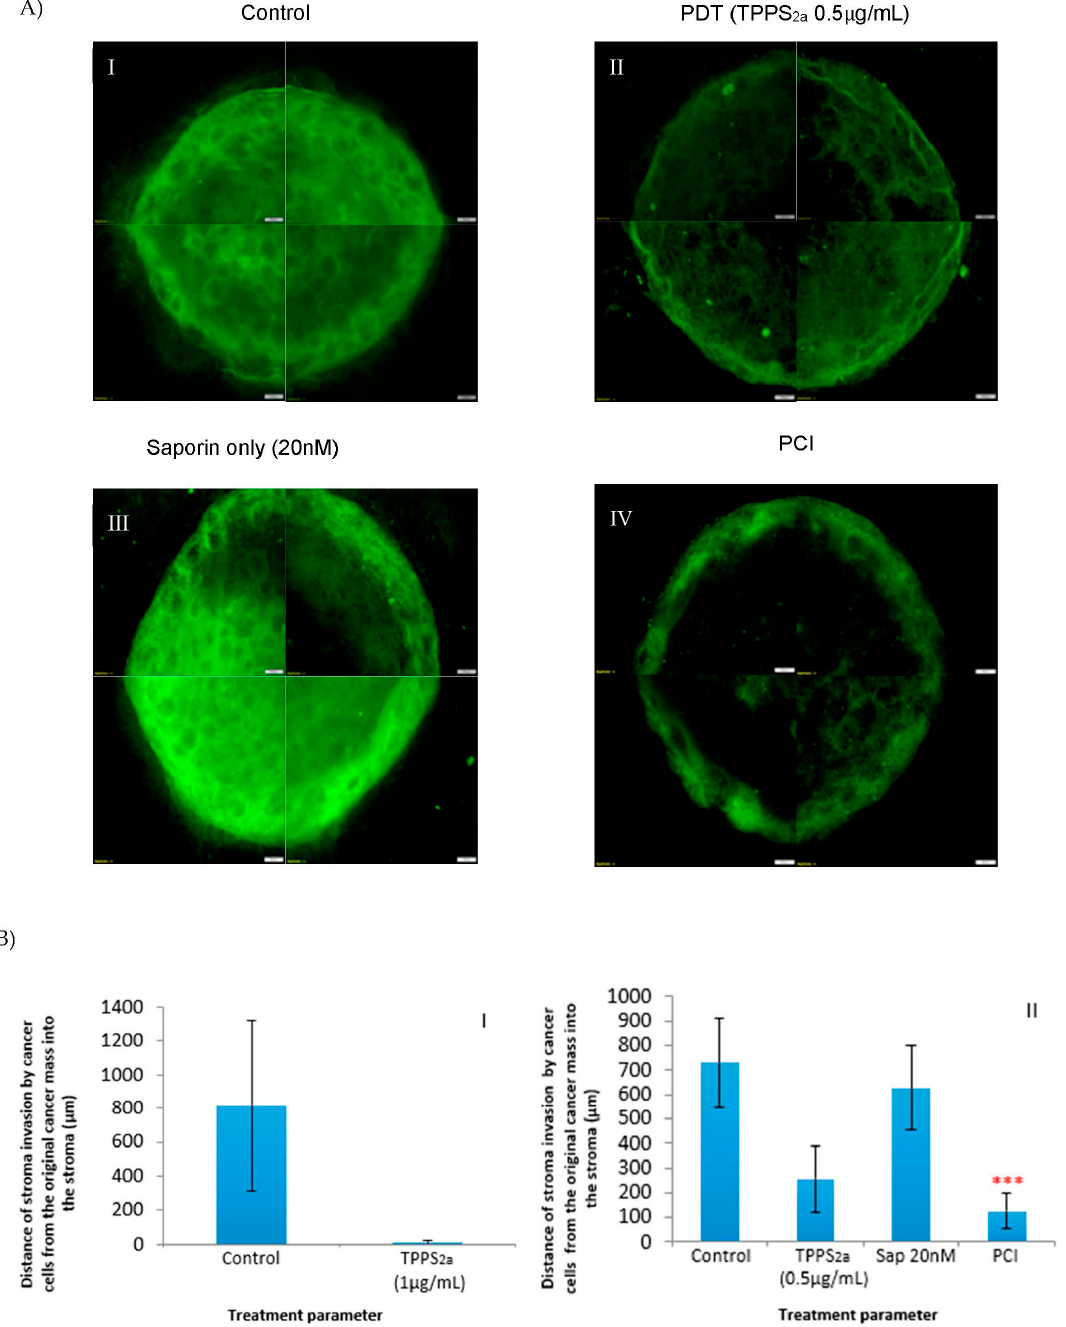
Figure 5. ( A ) Overall images of the cancer cell population stained with anti-cytokeratin 7 (Alexa Fluor 488) λ Ex/Em: 490/525 (green) within the central cancer mass of the simple tumouroids for each treatment condition; Control simple tumouroid construct ( I ), PDT in simple tumouroid